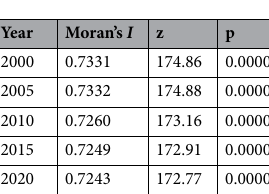
Table 4. Global Moran I of carbon storage from 2000 to